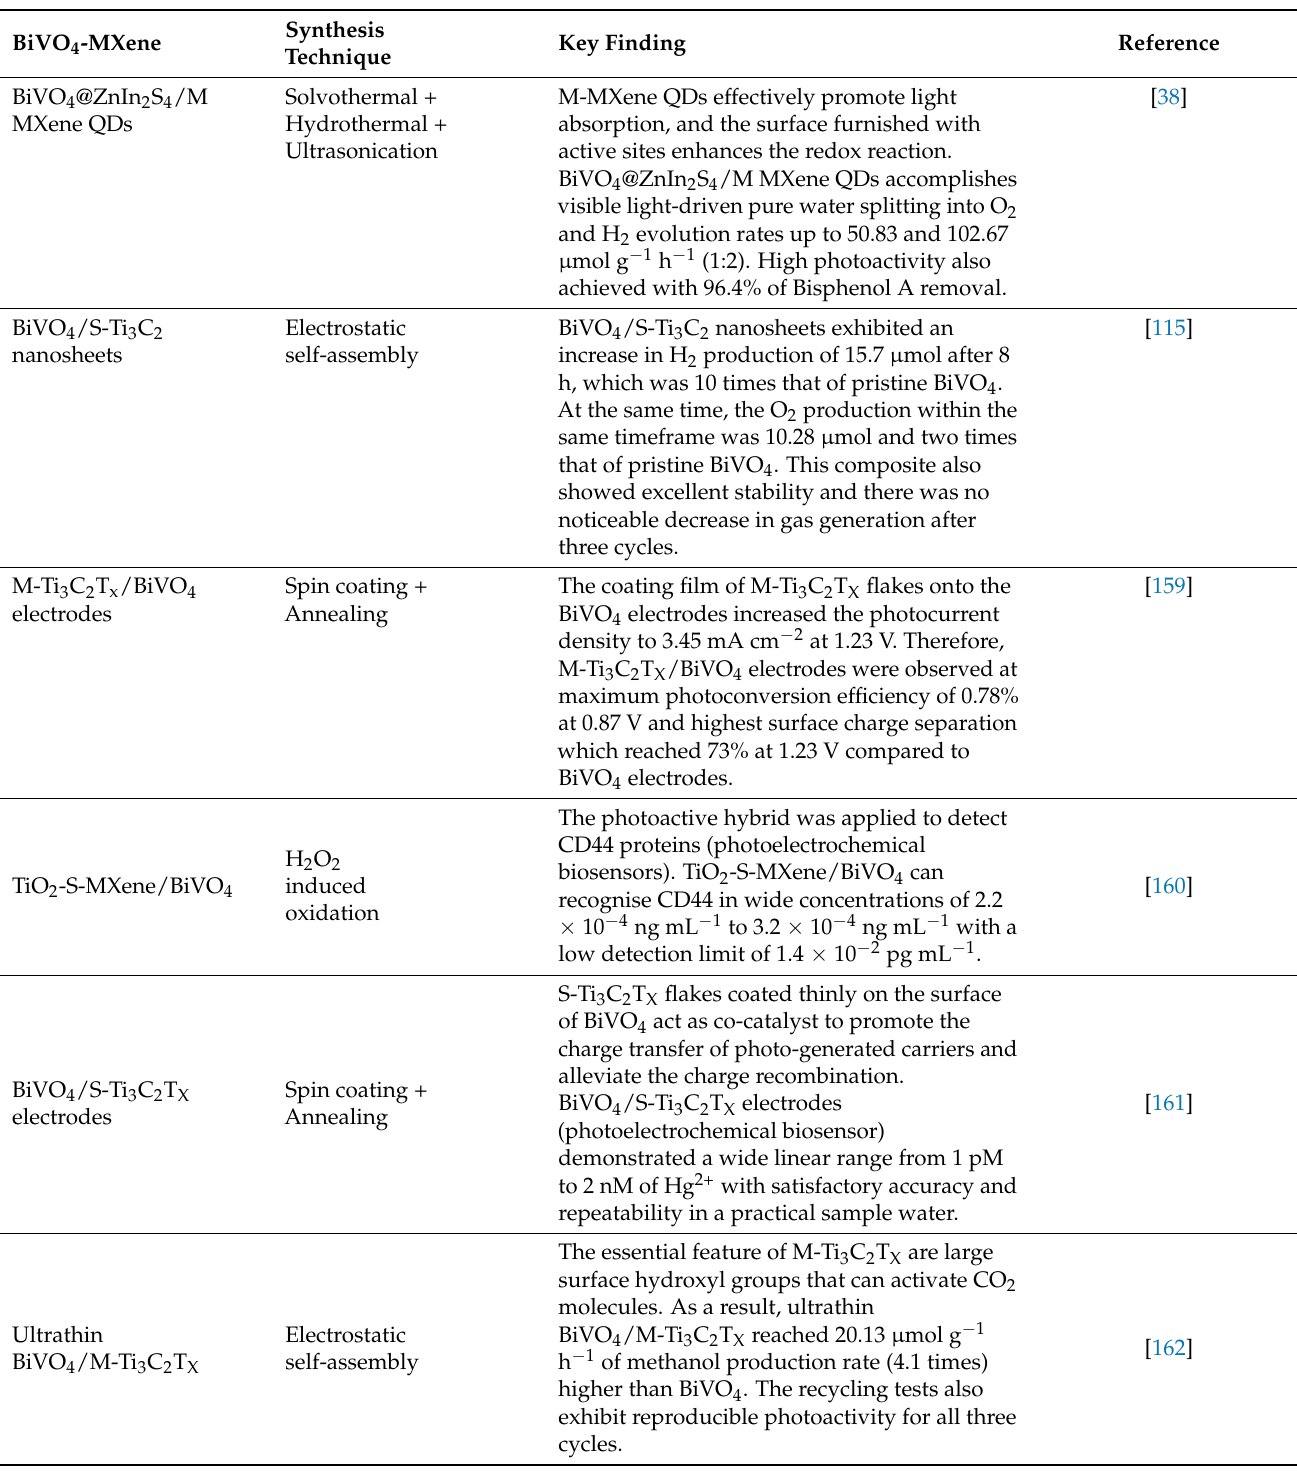
Table 7. Summary of BiVO 4 -MXene based photocatalysts synthesis